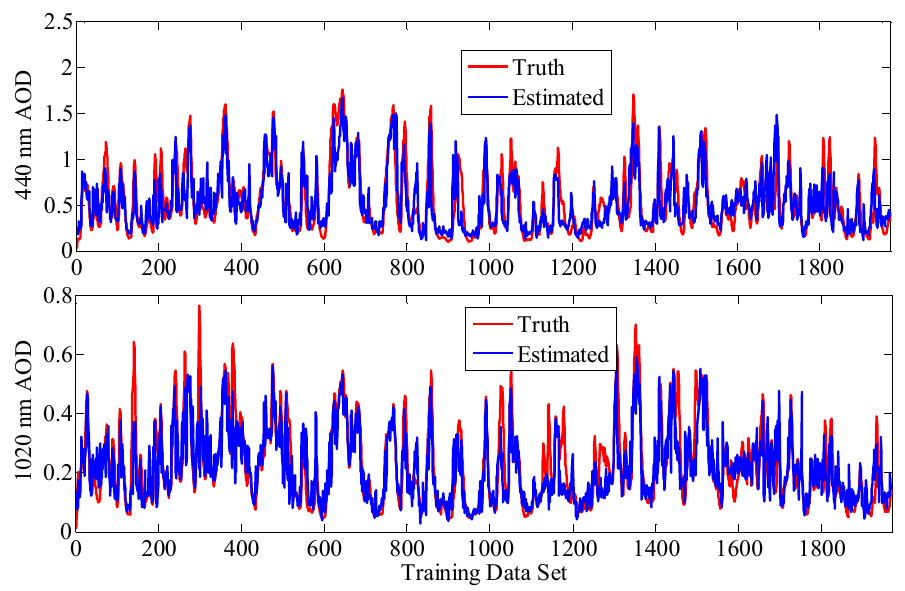
Figure 5. Estimation results of support vector machine (SVM) models on the training data set.